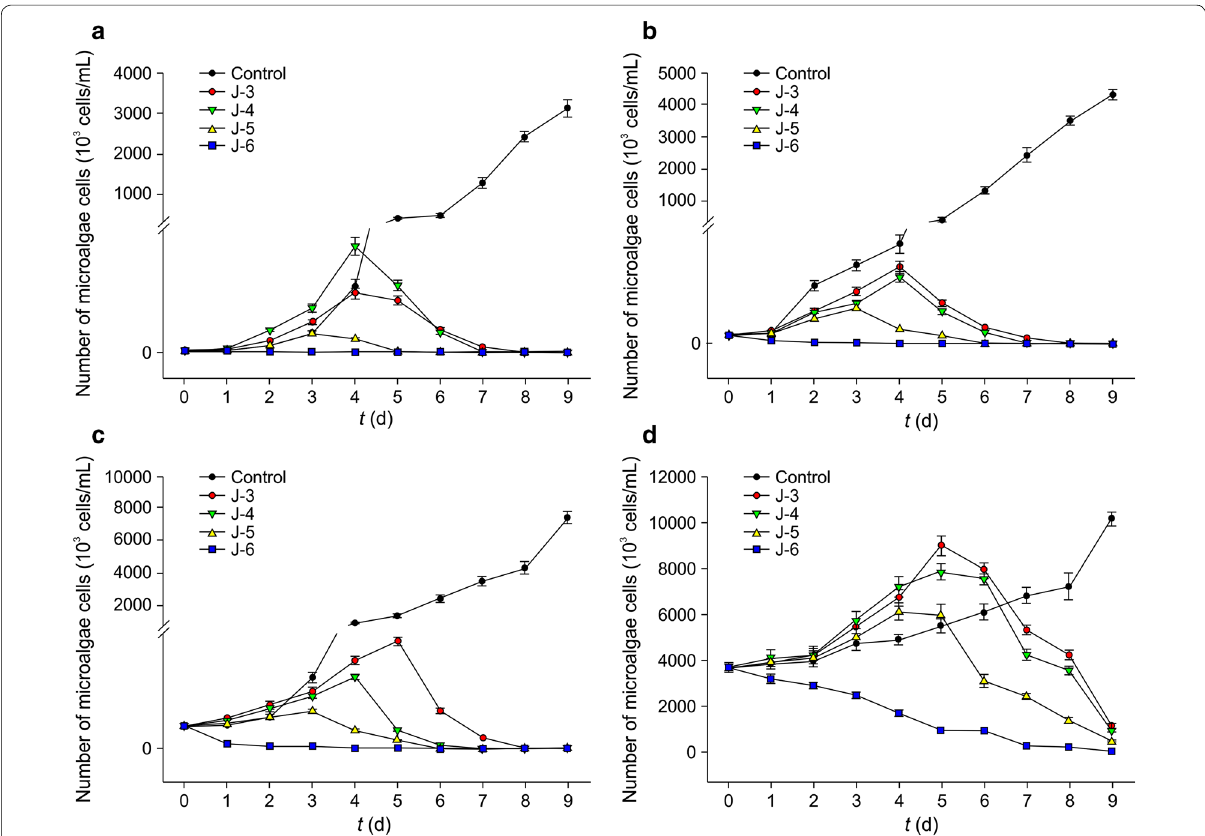
Fig. 9 Alginolytic effects of different initial concentrations of CZBC1 on Oscillatoria planctonica at different initial concentrations. a 10 3 cells/mL. b 10 4 cells/mL. c 10 5 cells/mL. d 10 6